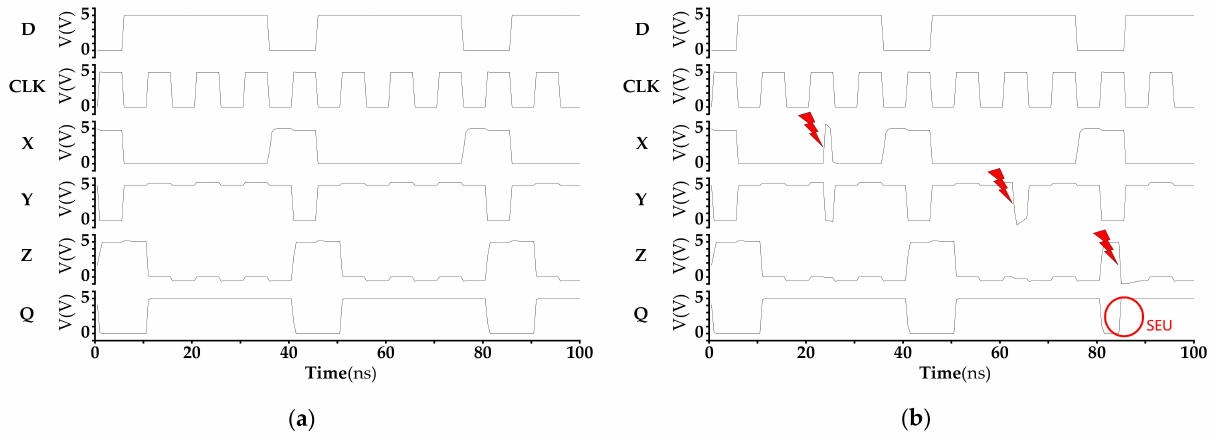
Figure 11. DM-TSPC: ( a ) simulation waveform of DM-TSPC without SETs; ( b ) simulation waveform of DM-TSPC with